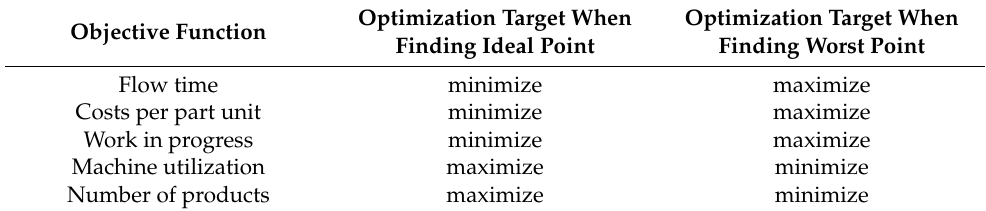
Table 5. The target of the single-objective